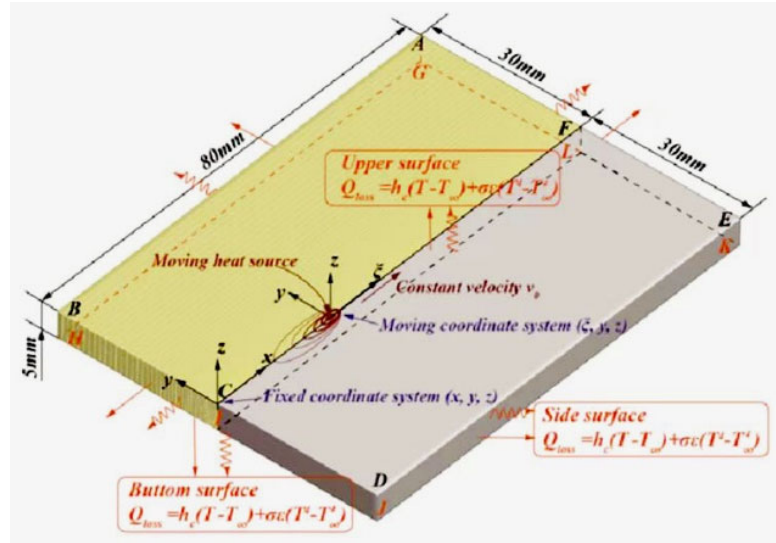
Figure 4. Heat and mass transfer model of molten pool.